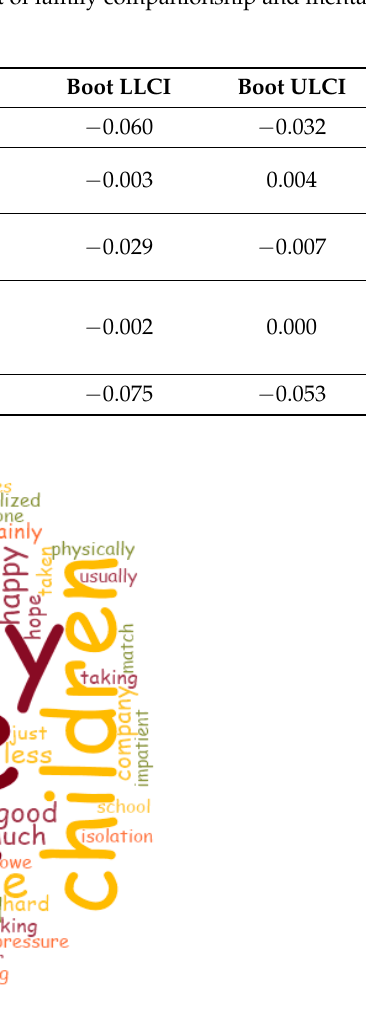
Figure 3. The word cloud of open ‐ ended survey responses. Table 6. List of themes and subthemes of the open ‐ ended survey responses.